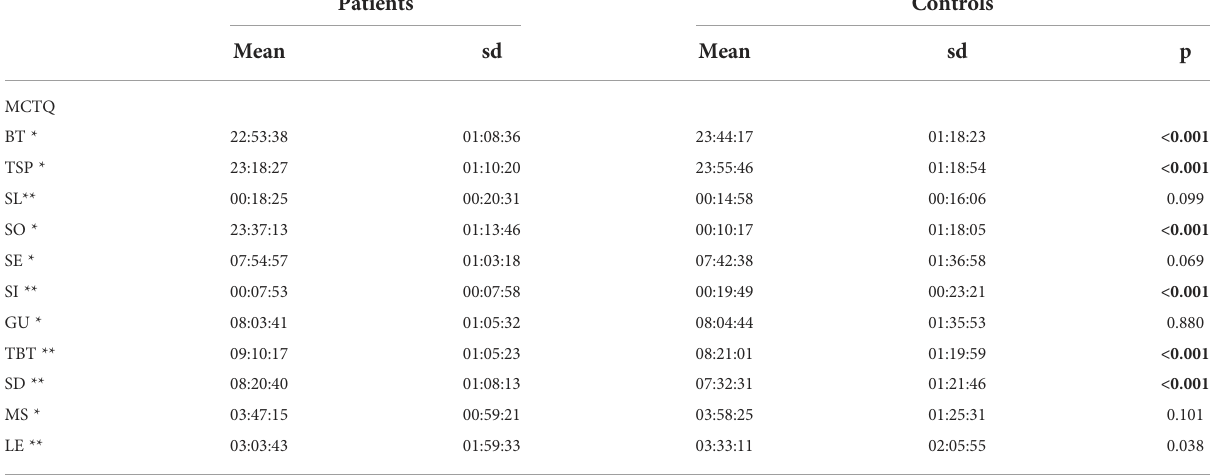
TABLE 2 Sleep patterns in patients and